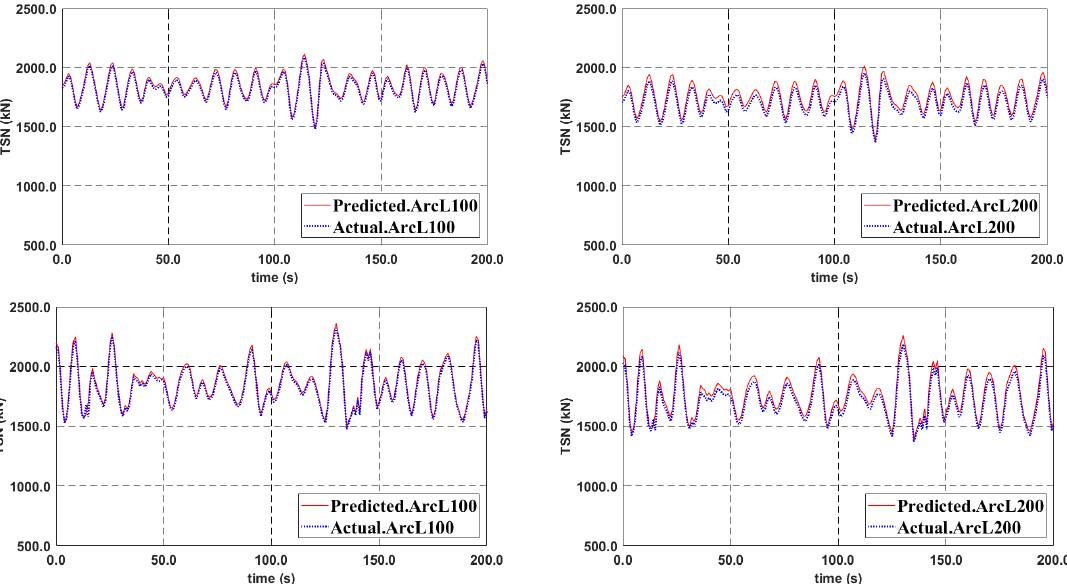
Figure 12. Tension Estimation up to Target Point, 1-yr Storm ( Up ) and 100-yr Storm ( Down ), WD1000, SCR, Sensor Interval = 100 m.